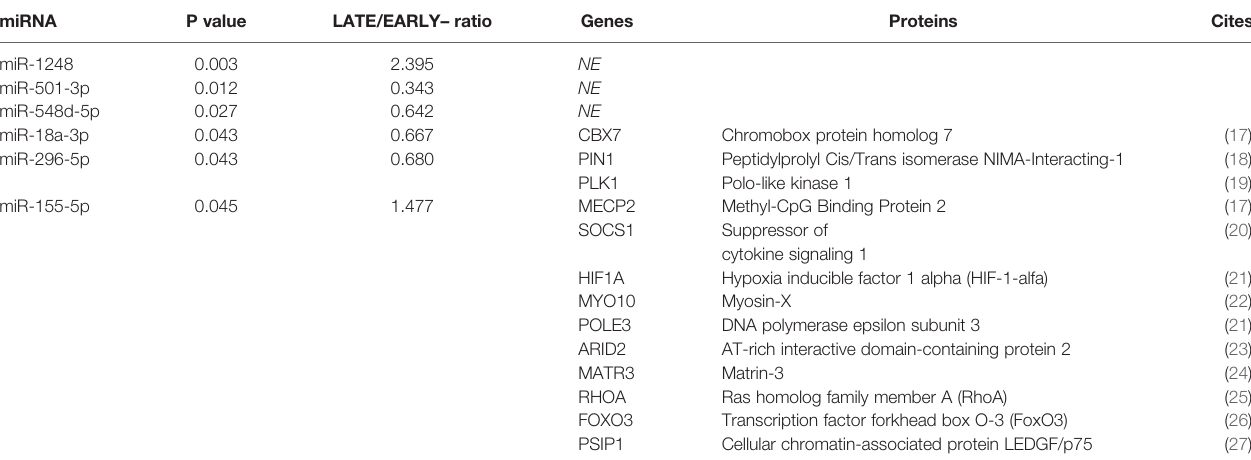
TABLE 3 | Differentially expressed miRNAs between LATE and EARLY treated HIV-1-young adults and list of targeted genes involved in HIV immunopathogenesis. miRNA P